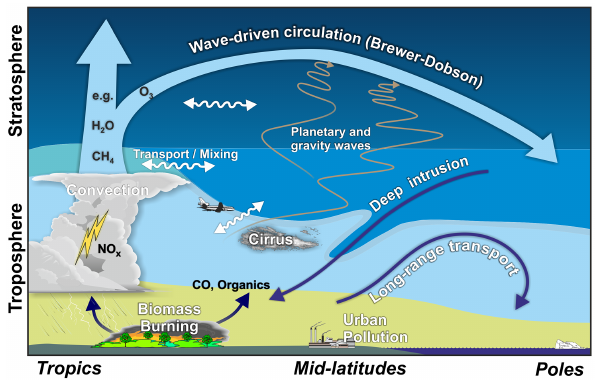
Figure 1. Processes that determine UTLS composition. The mid- dle shaded blue region is the lowermost stratosphere (LMS), where isentropic surfaces cross the tropopause and facilitate quasi- horizontal transport (middle white wave-like arrow). More details on transport in the tropopause region are given in Fig.